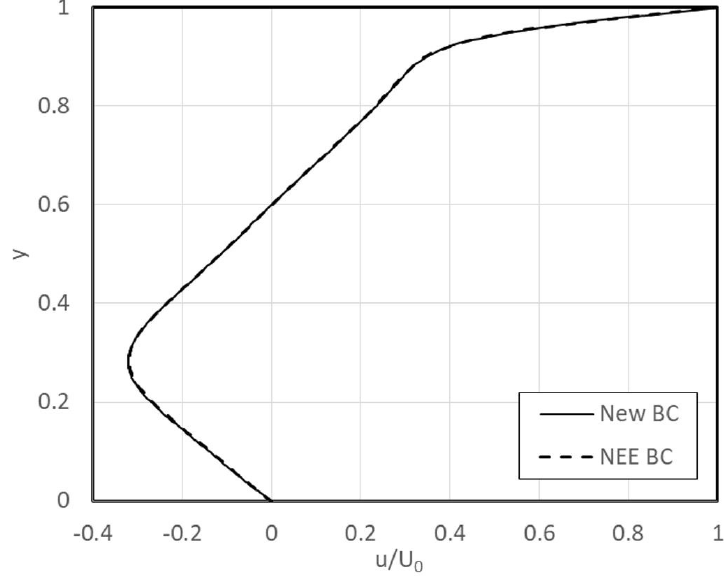
Figure 16. Variation of streamwise velocity profiles between the newly developed and NEE boundary